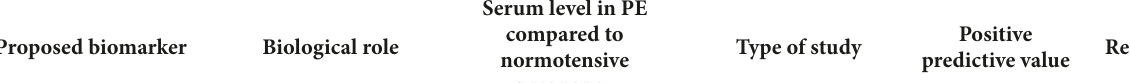
Table 2: List of proposed serum biomarkers for the detection and diagnosis of